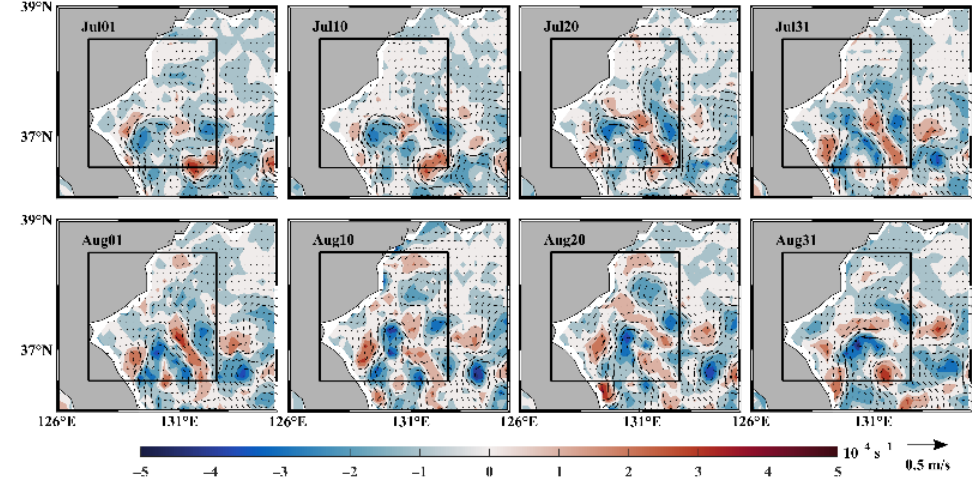
Figure 10. Sea surface geostrophic velocity anomalies (arrows, units: m/s) and related relative vorticities (color, units: s − 1 ) from 1st July to 31 August 2021. The black box is the study area.